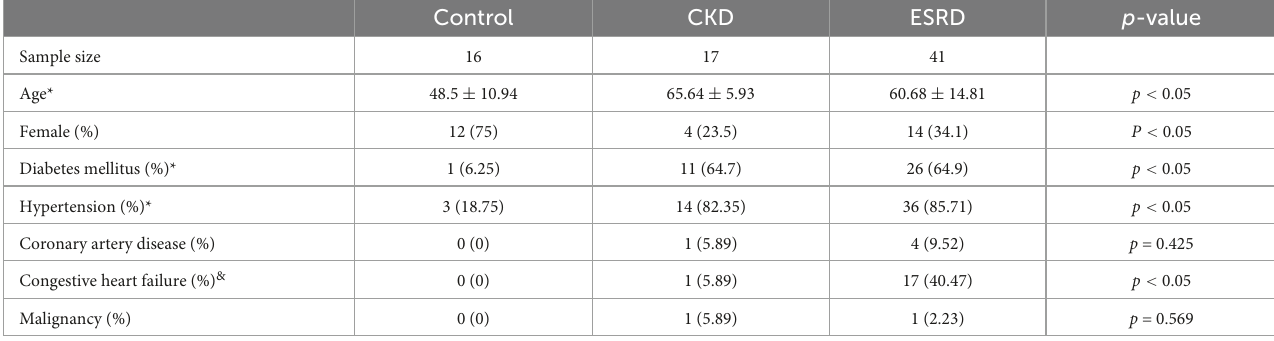
TABLE 1 Patient demographics by group.